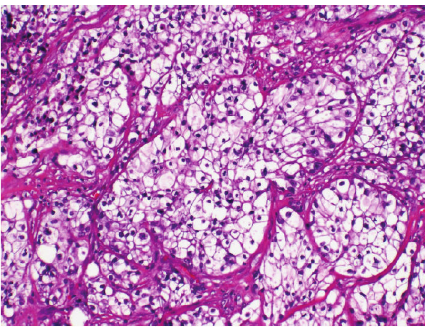
Figure 2: Poorly differentiated nonkeratinizing deeply infiltrating tumor with foci of duct formation. H&E original magnification × 200.